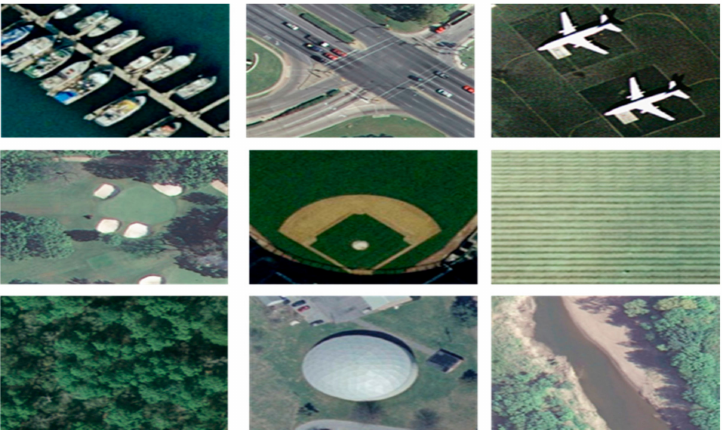
Figure 10. A few classes of Aerial Image Dataset having rich texture features with diverse back-